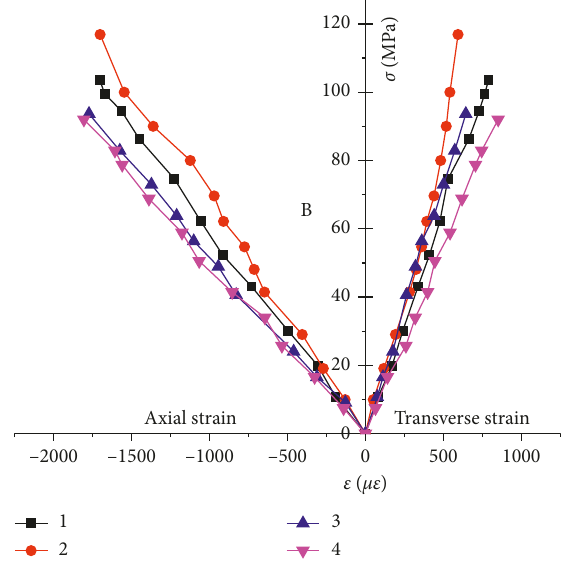
Figure 4: Stress-strain curve of the granite stone cylinder.